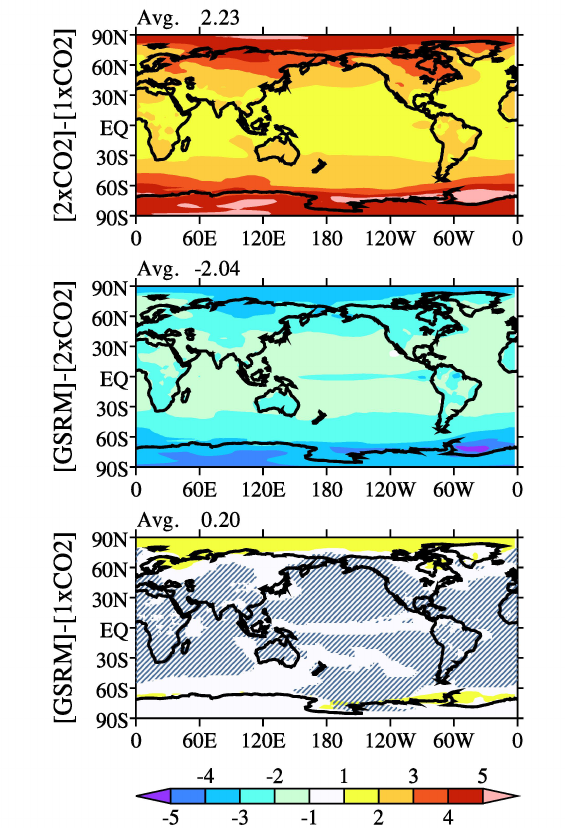
Fig. 1. Model-calculated changes in climatological annual-mean surface air temperature (in Kelvins) in response to specified changes in radiative forcing. The top figure shows the temperature change for 2 × CO 2 as compared with 1 × CO 2 , indicating that the warm- ing in high latitudes is 2–3 times the warming in low latitudes. The middle figure shows the temperature change that results from im- posing a globally uniform reduction in insolation of 1.8% starting from the 2 × CO 2 baseline, showing changes in high latitudes con- siderably larger than in low latitudes. The bottom figure shows the remaining temperature change as a result of imposing the CO 2 dou- bling and a 1.8% global reduction in insolation. The hatching in- dicates areas where the changes are not statistically significant at the 95% confidence level using a modified Student’s t test for auto- correlated data (Zwiers and von Storch, 1995).